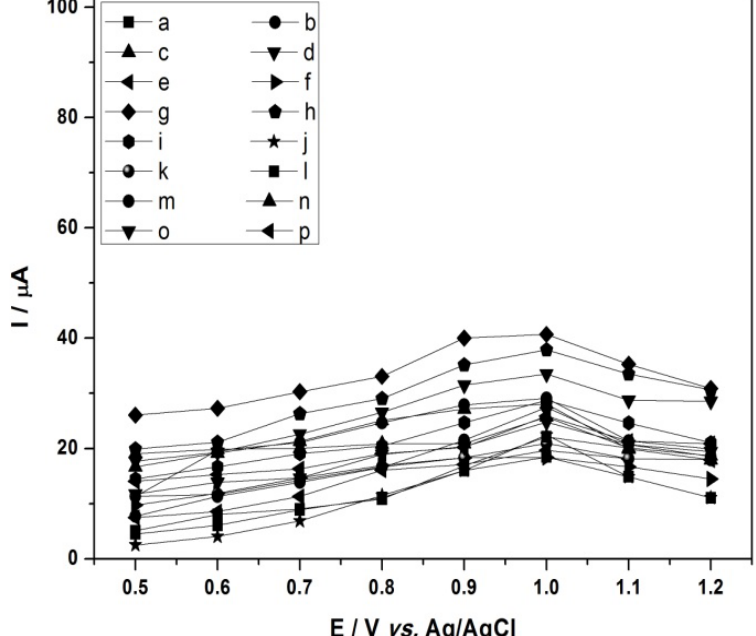
Figure 5. Hydrodynamic voltammograms of a 24 mg·L − 1 standard of: a :